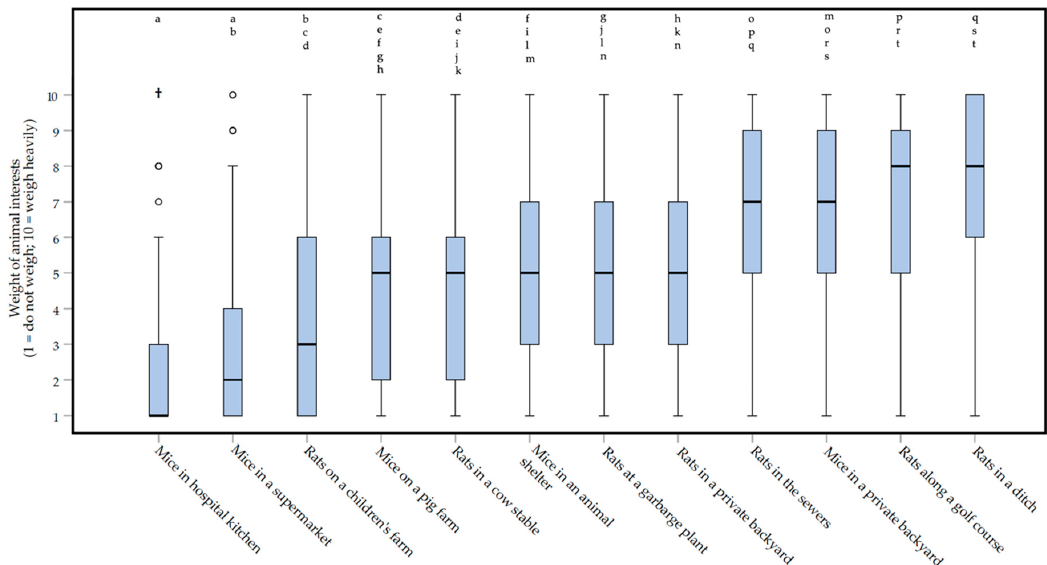
Figure 6. Box plots presenting the importance of the interests of rats ( Rattus rattus and Rattus norvegicus ) and mice ( Mus musculus ) in twelve di ff erent real-life scenarios in rodent control according to 129 Dutch pest controllers, participating in an online survey. Interests of rats and mice were defined as living, freedom, and welfare. Weight of interests could be indicated on a 1 (do not weigh) to 10 (weigh heavily) interval rating scale. Outliers and extreme cases are indicated with o and † , respectively. Di ff erences between the two scenarios that are not statistically significant are indicated with letters above the bars.